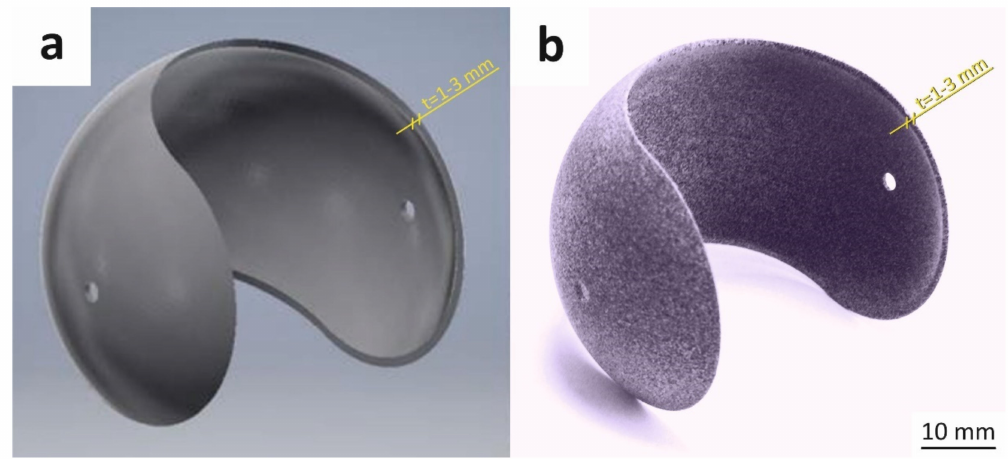
Figure 2. The overview of 3D model ( a ) and printed part ( b